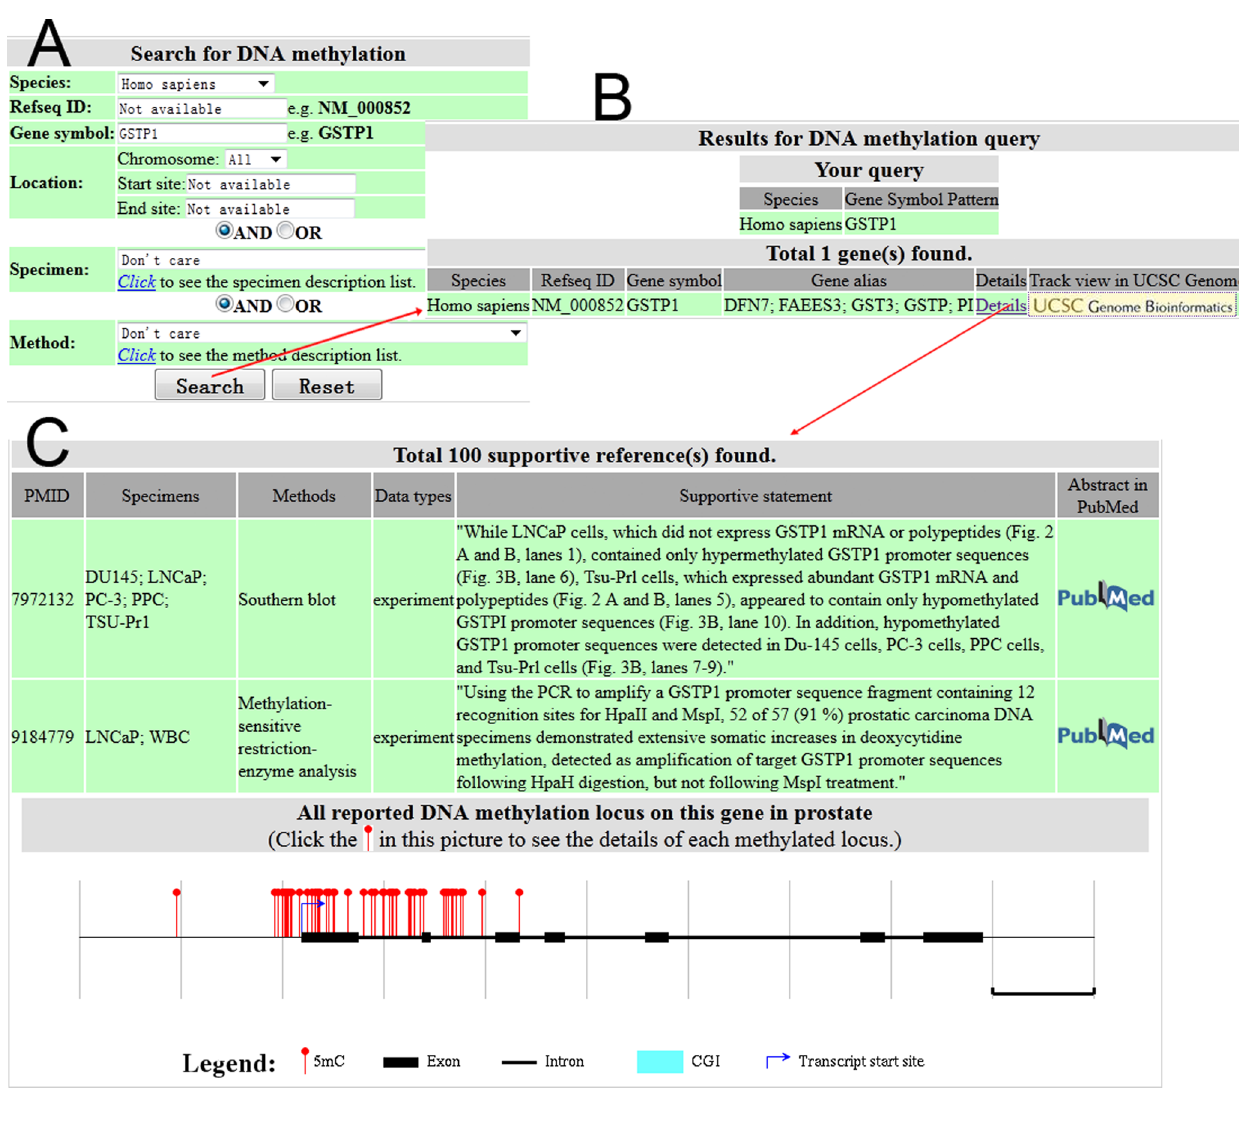
Figure 1. Screen shots showing DNA methylation query by Gene symbol GSTP1 in human. A, the search form page in which the exclusion relationship between Refseq ID, Gene symbol, and Location is indicated. B, the query result page embedded with the link to track view in UCSC genome browser. C, the details page showing supportive references and DNA methylation loci in a graph.